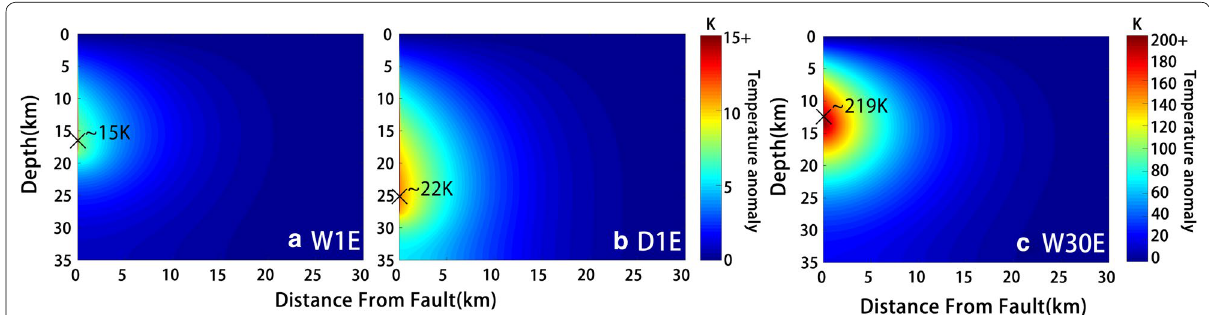
Fig. 6 Temperature anomaly produced by shear and frictional heating versus depth and distance from the fault for models a W1E, b D1E and c W30E after 3 Myr of fault sliding. “ × ” shows the location of maximum temperature increase; numbers indicate the magnitude of maximum tempera- ture